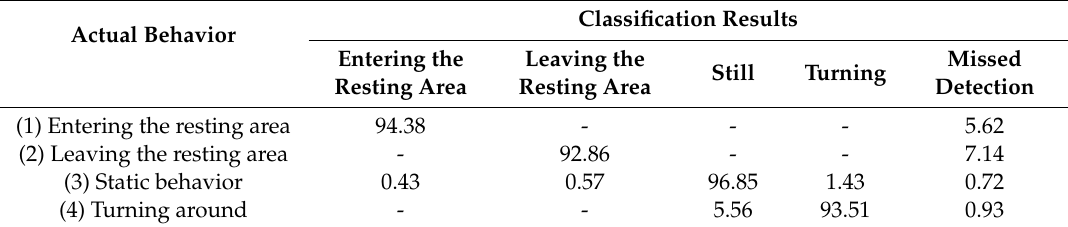
Table 1. Results of calf’s behaviors recognition rate (%).